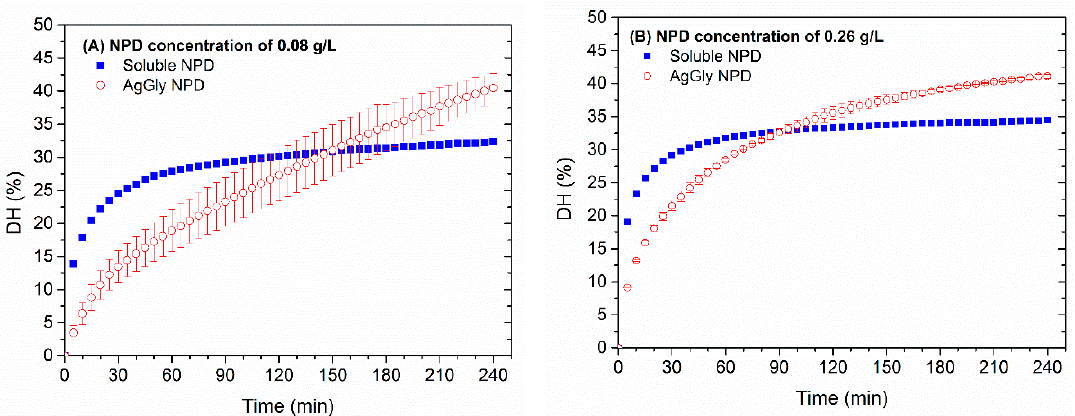
Figure 11. Profile of hydrolysis of casein (26 g/L) at 50 °C, pH 6.5 and 500 rpm stirring catalyzed by free and immobilized NPD (AgGly-NPD loaded with 18.9 mg protein/g support) using an enzyme concentration in the reactor of ( A ) 0.08 g/L and ( B ) 0.26 g/L.